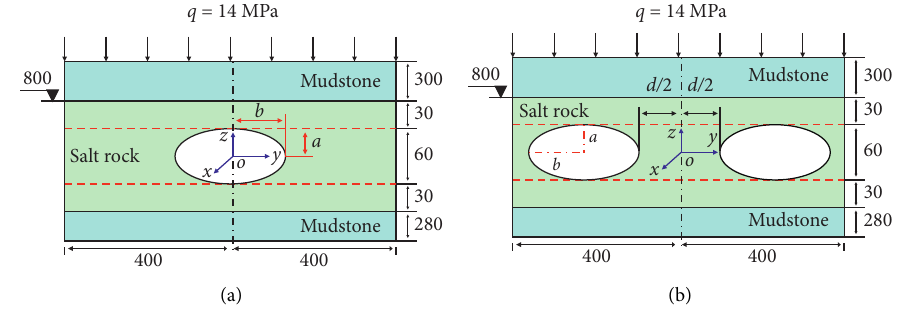
Figure 2: Schematic diagram of the numerical model of horizontal salt rock storage (unit: m). (a) Single cavern and (b) double